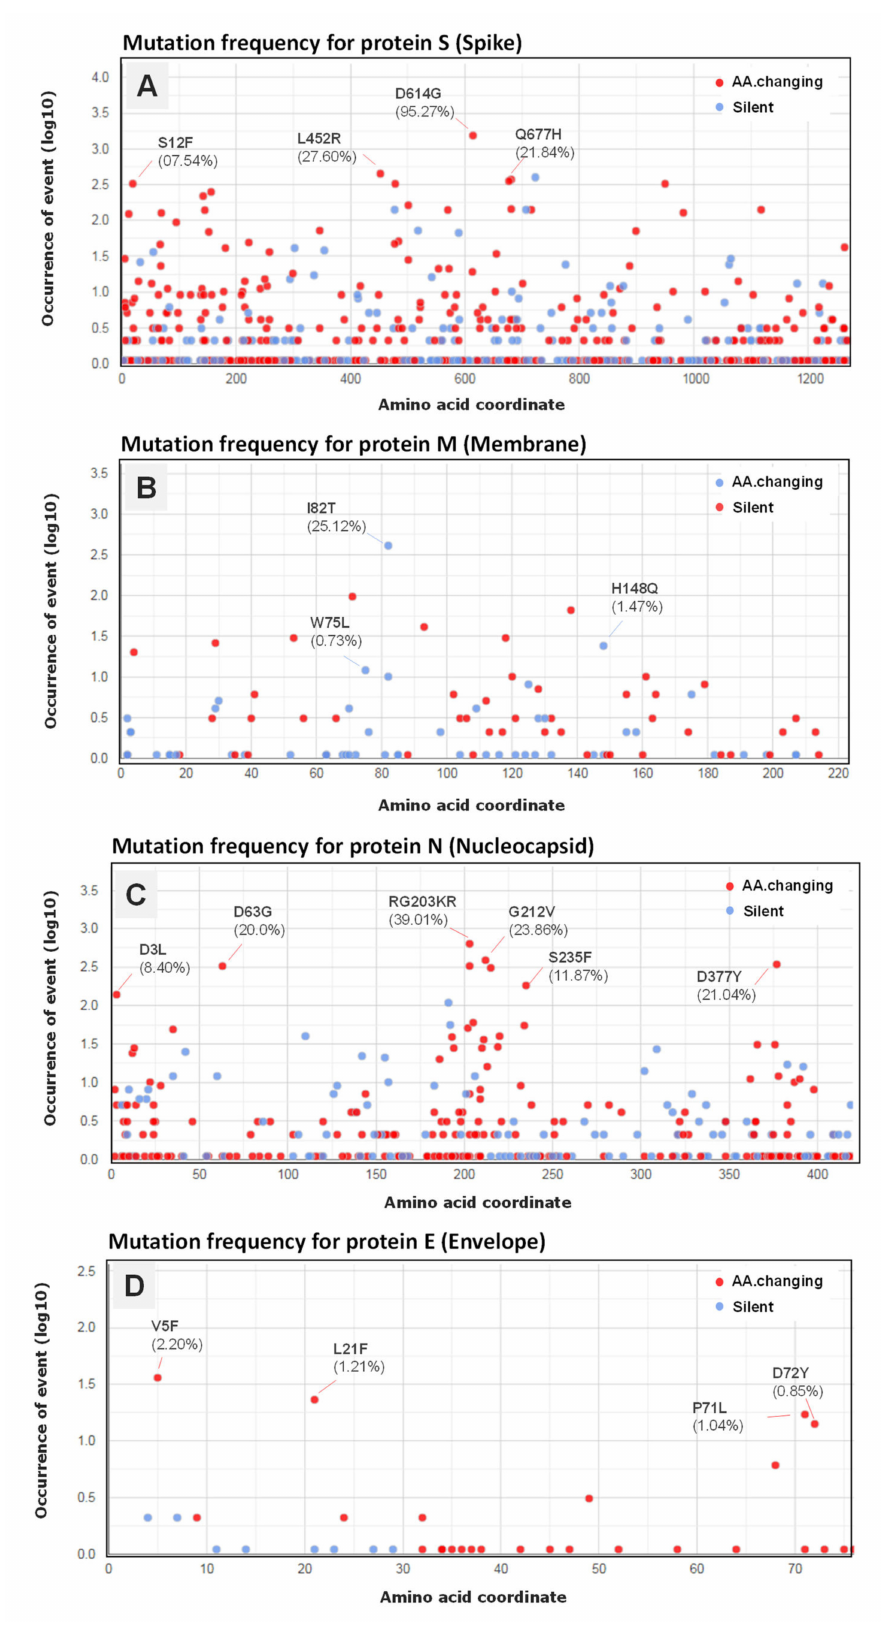
Figure 7. Occurrence of mutations in the SARS-CoV-2 structural proteins S (Spike) ( A ), M (Membrane) ( B ), N (Nucleocapsid protein ( C ), and E (Envelope ( D ). The frequency (in percentage) of the top amino acid- changing mutations is